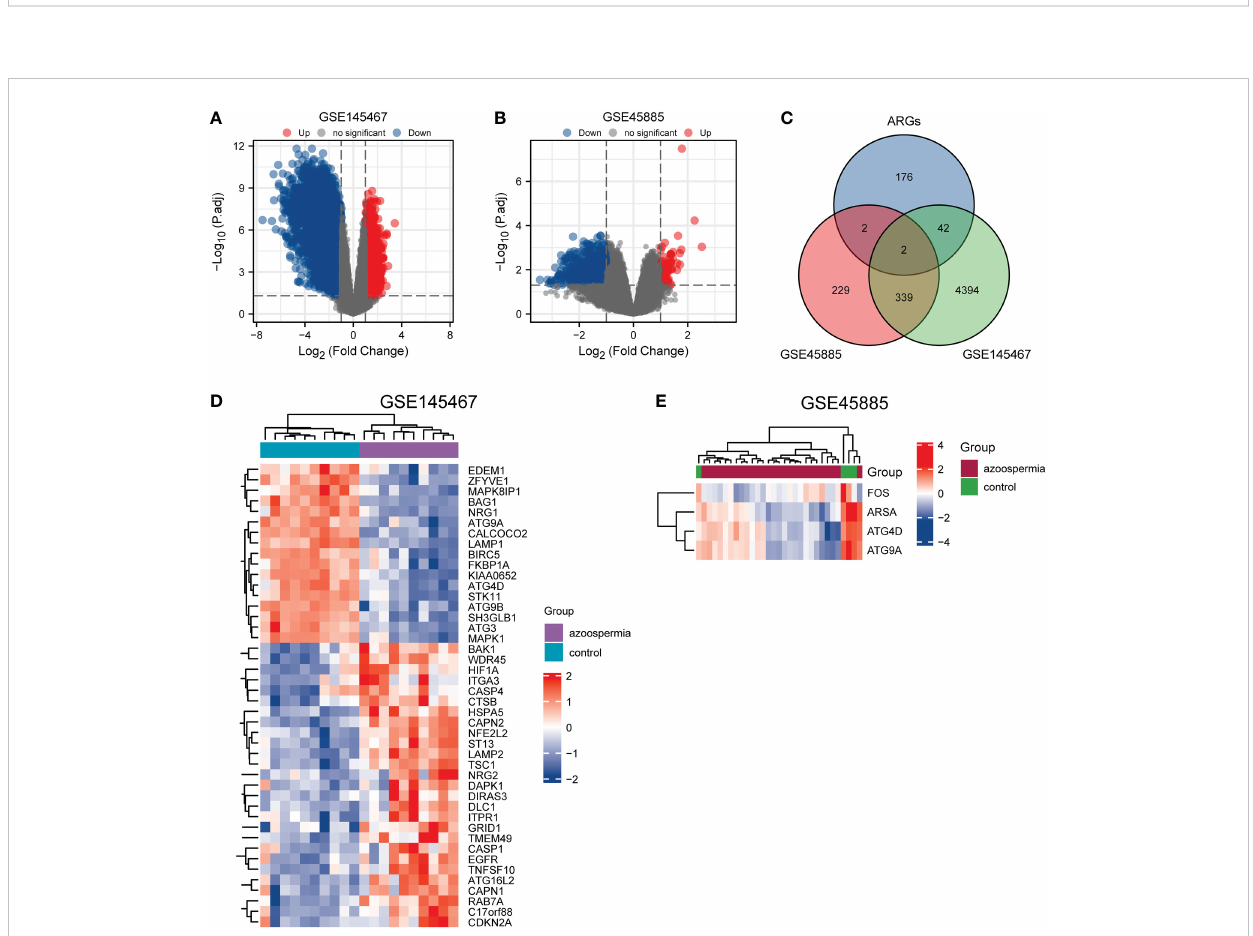
FIGURE 2 Identi fi cation of autophagy-related differentially expressed genes (ARDEGs). (A) and (B) : Volcano maps of differentially expressed genes () in GSE145467 and GSE45885, respectively. Abscissa is log2 fold change and ordinate is − log10 (P value). Red nodes represent upregulated differentially expressed genes, blue nodes represent downregulated differentially expressed genes, and gray nodes represent genes that are not signi fi cantly differentially expressed. (C) : Venn diagram of DEGs and autophagy-related genes. (D) and (E) : Heatmaps of ARDEGs in GSE145467 and GSE45885, respectively. Red represents high expression, and blue represents low